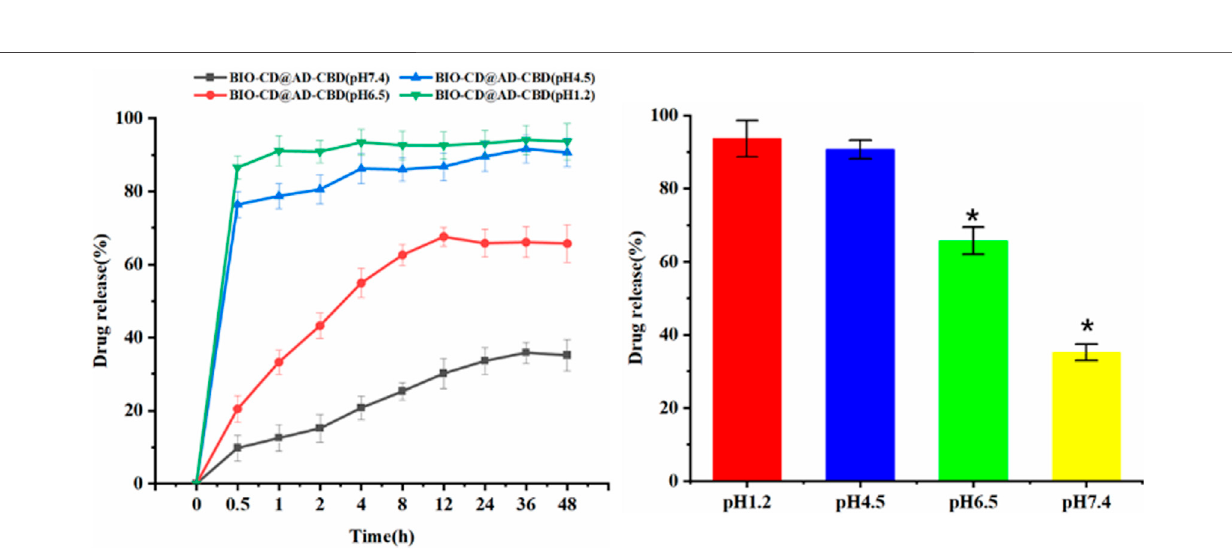
FIGURE 10 | Release pro fi les of guest molecular under different pH buffer